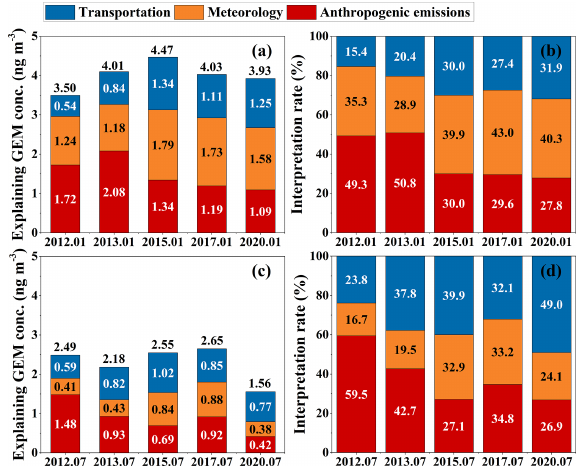
Figure 7. The explaining concentration (ng m − 3 ) (a, c) and inter- pretation rate (%) (b, d) of the three factors to the variation of GEM concentrations during the study years.